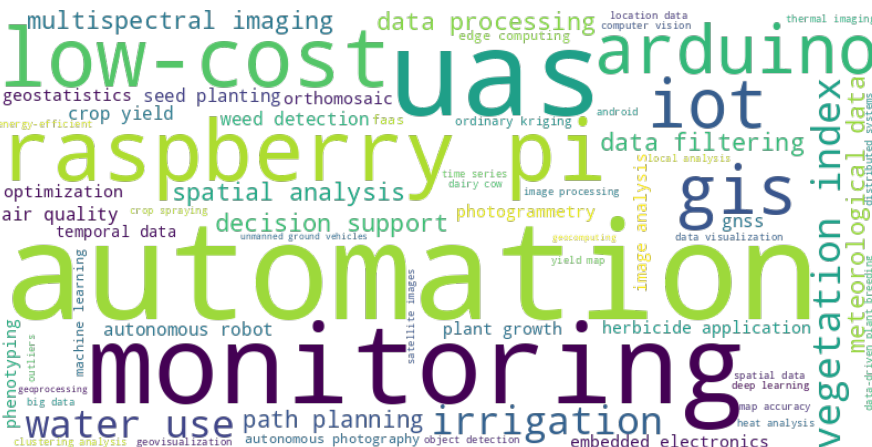
Figure 5. Word cloud highlighting the most frequent keywords found in the selected works (see Table